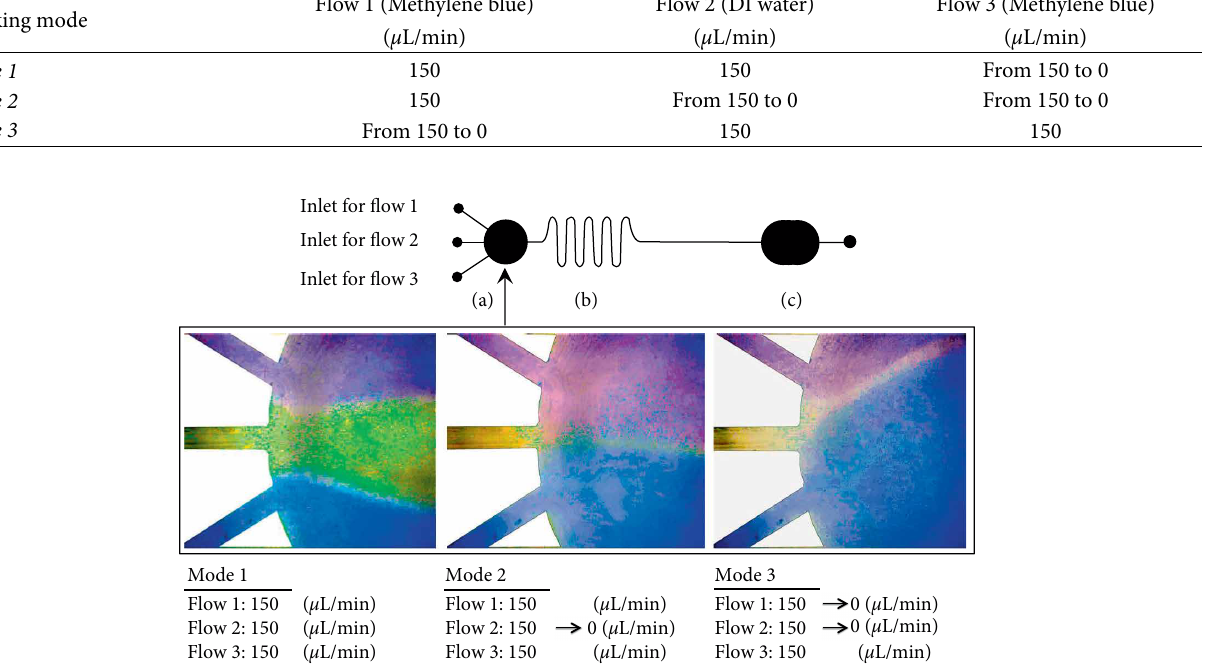
Figure 6: Test results of the mixing process of three liquid flows: two methylene blue solutions and DI water. Microfluidics: (a, b) the mixing module, and (c) the